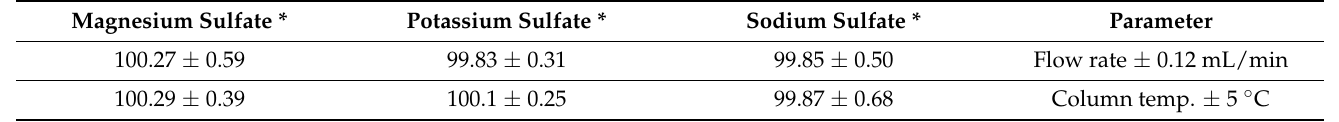
Table 3. Robustness of the proposed methods for the determination of sodium, potassium, and magnesium